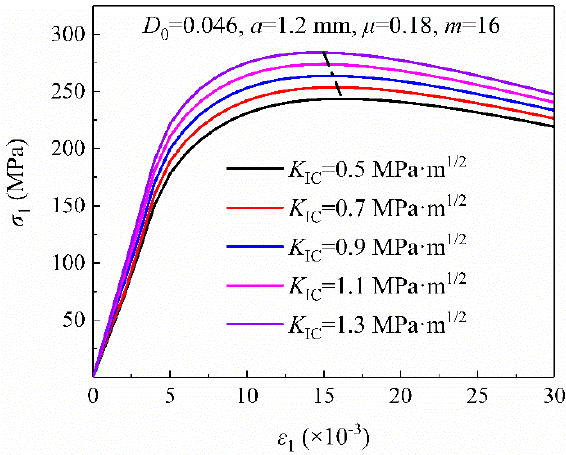
Figure 14. Effects of fracture toughness K IC on stress-strain relationship.